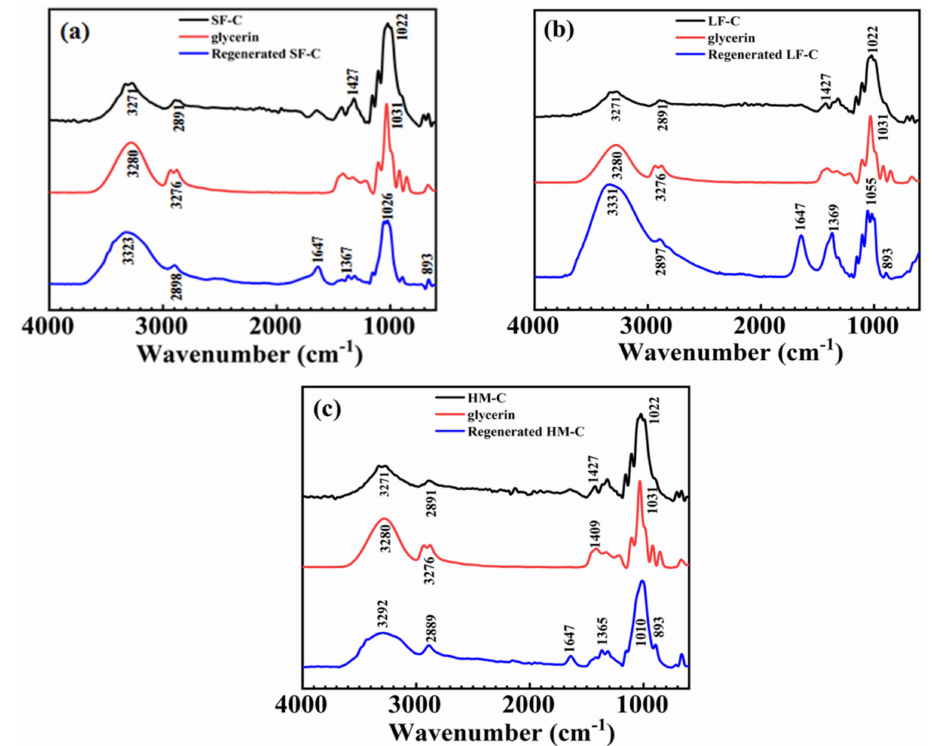
Figure 5. FTIR spectra of the cellulose, glycerin and regenerated cellulose from its glycerin / NaOH aqueous solution: ( a ) SF-C; ( b ) LF-C; ( c )